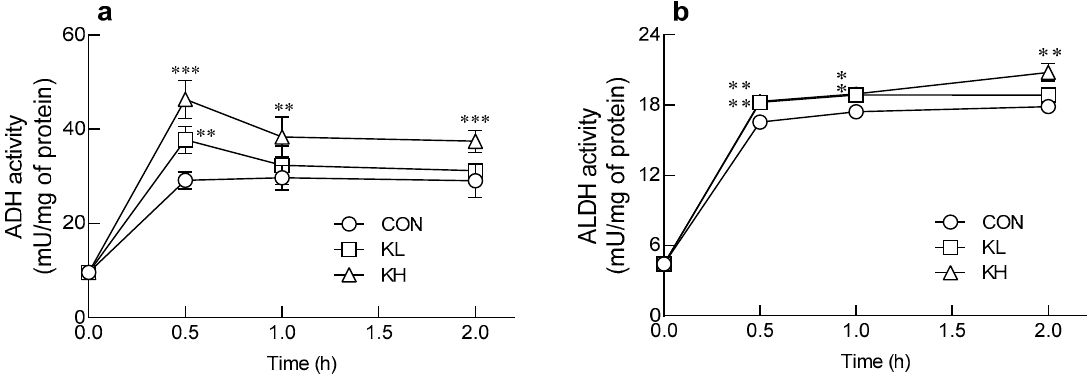
Figure 6. Effect of GBK on ( a ) ADH activity and ( b ) ALDH activity in mouse liver tissues. Values are mean ± SEM. GBK was administered orally 30 min before ethanol administration. * p < 0.05, ** p < 0.01, and *** p < 0.001 vs. CON group (ANOVA followed by Tukey’s test). ADH, alcohol dehydrogenase; ALDH, acetaldehyde dehydrogenase; CON, control group; KL, low-dose GBK group (15 mg/kg); KH, high-dose GBK group (30 mg/kg).